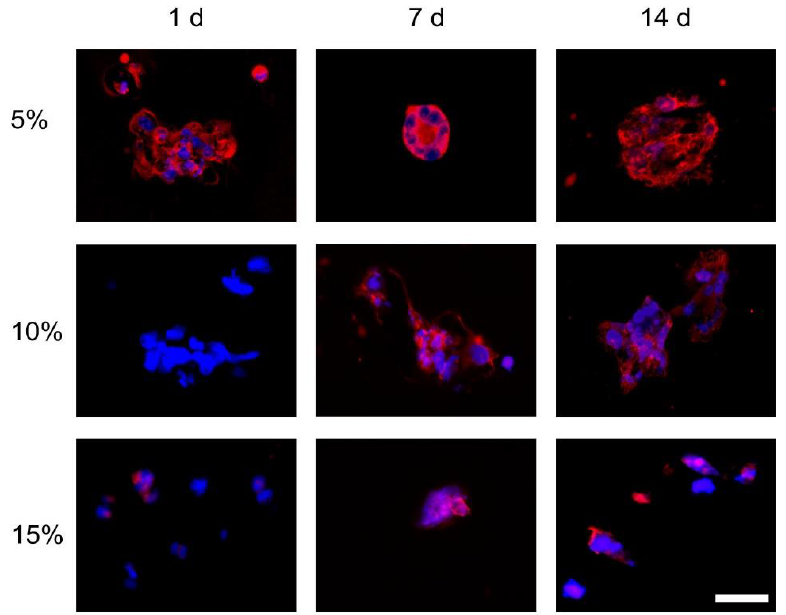
Figure 3. ASCs morphology in 5%, 10%, and 15% GelMA at 1 d, 7 d, and 14 d. Sections stained with DAPI and Phalloidin. Representative images are shown. Scale bar represents 25 µm, all fluoromicrographs have the same original magnification.